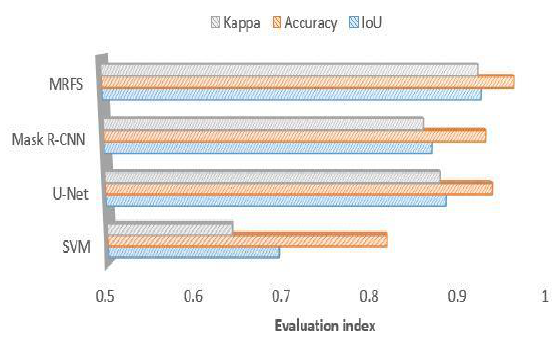
Figure 9. Comparison of MRFS, Mask R-CNN, SVM and KNN(k-Nearest Neighbor) on large building extractions.